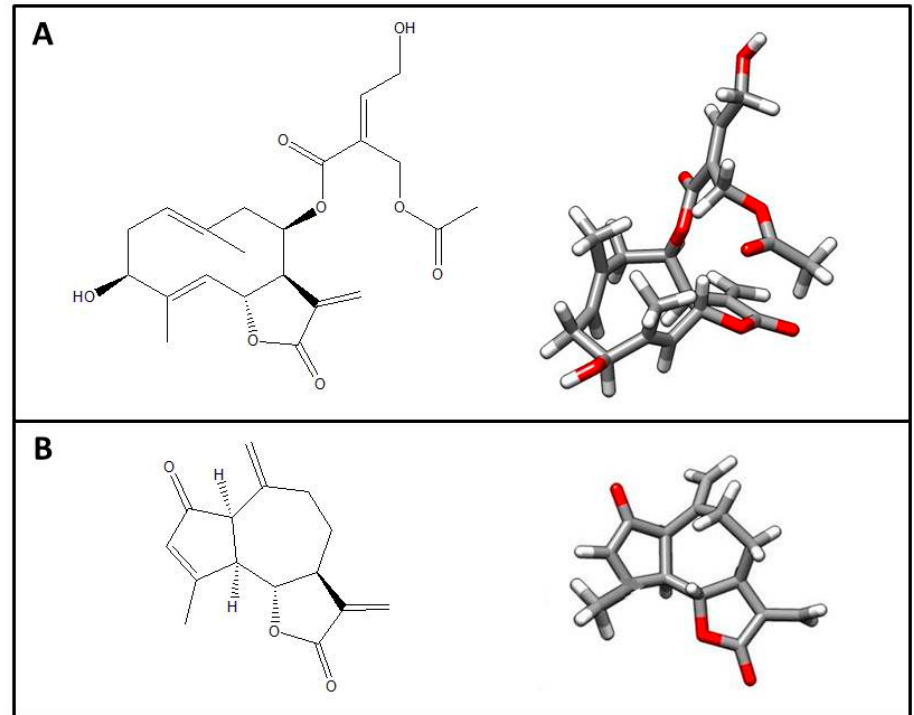
Figure 1. Two- and three-dimensional structures of isolated compounds: ( A ) santhemoidin C; ( B ) 2-oxo-8-deoxyligustrin.